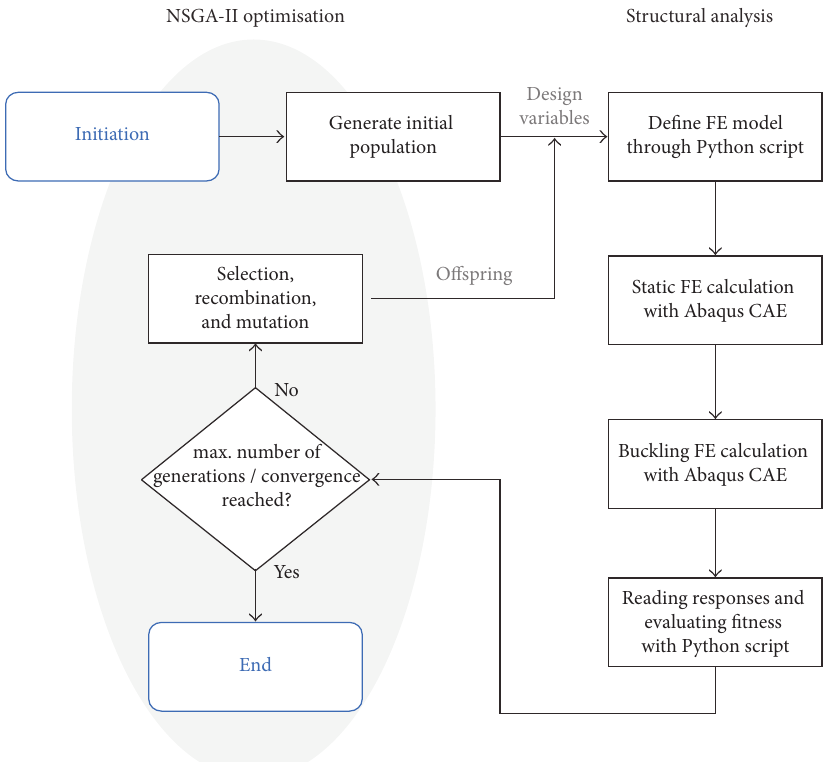
Figure 4: NSGA-II generates a first population that is sent to Abaqus for static and dynamic calculations. The output is sent back to Matlab to calculate the fitness